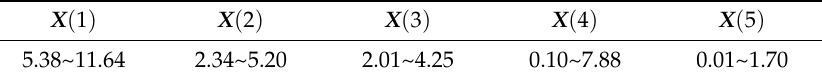
Table 5. The search space of X ( 1 : 5 ) defined by